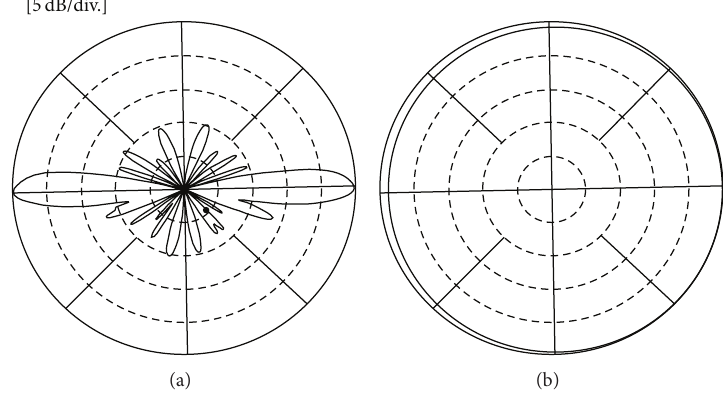
Figure 6: Measured radiation patterns of collinear antennas (V antennas). (a) Vertical plane. (b) Horizontal plane.